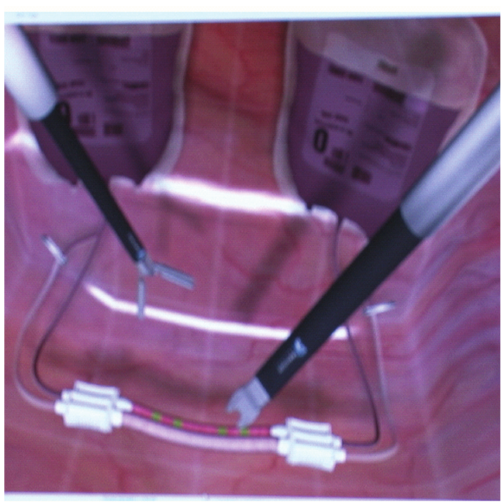
Figure 2: Clipping skills using the VR.